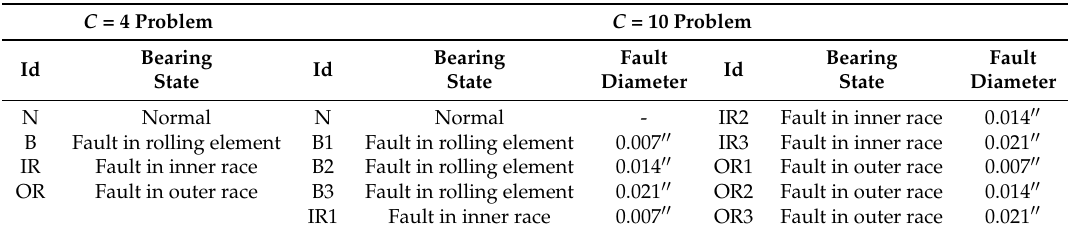
Table 3. Description of the different diagnosis/detection scenarios considered for bearing condition